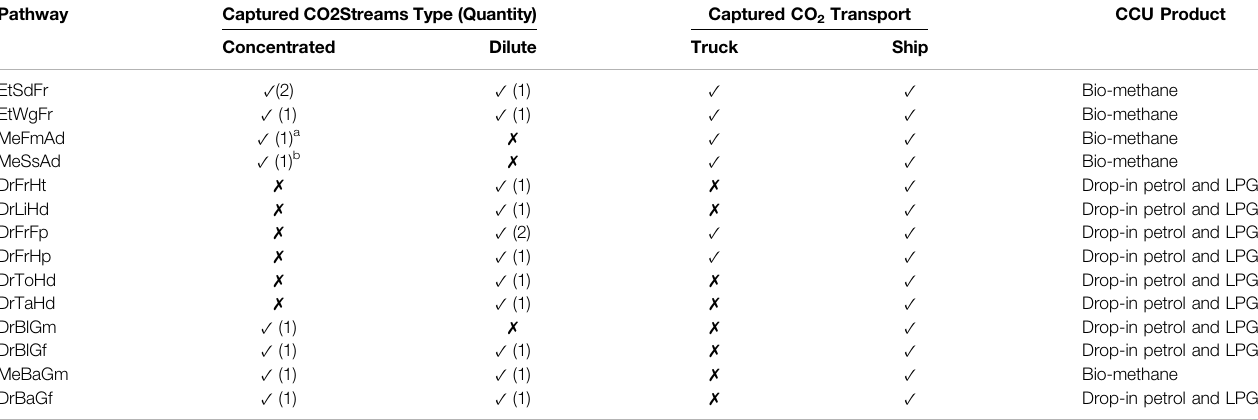
TABLE 3 | Logistics and design of CO 2 capture, transport and upgrading under the carbon capture and storage (CCS) and carbon capture and utilization (CCU) options.